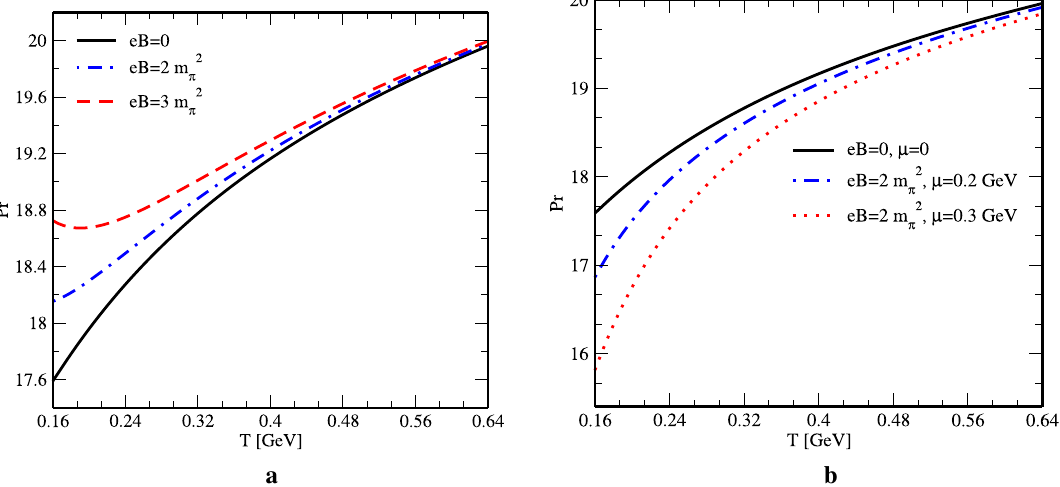
Fig. 4 The variation of the Prandtl number with temperature ( a ) in the presence of weak magnetic field and ( b ) in the presence of finite chemical potential